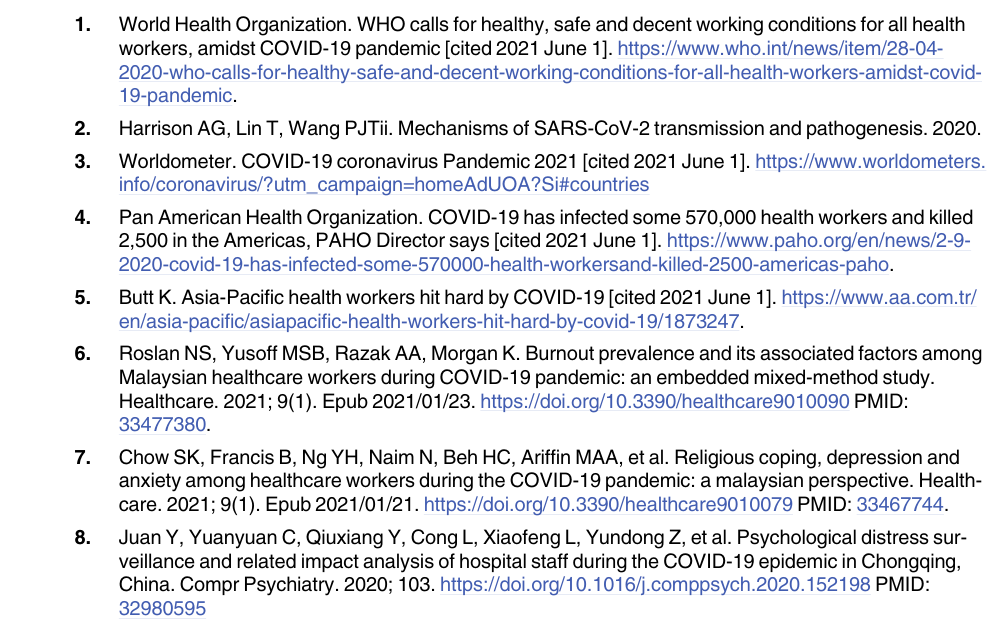
S1 Table. PRISMA checklist. S2 Table. Search terms used from 13 th of March to 15 th of March 2021. S3 Table. Strobe checklist. S4 Table. Characteristics of 148